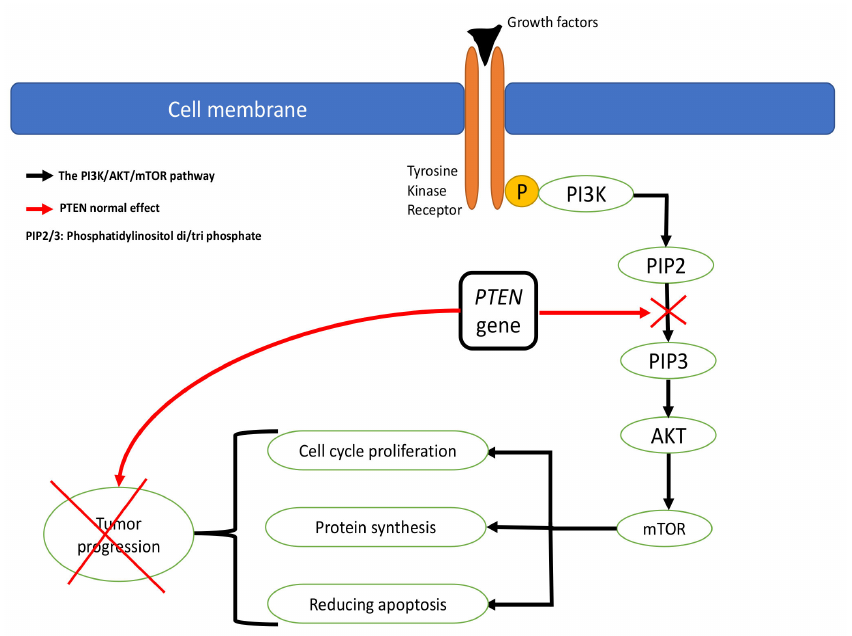
Figure 1. Illustration of the PI3K/AKT/mTOR pathway and regulation by the PTEN